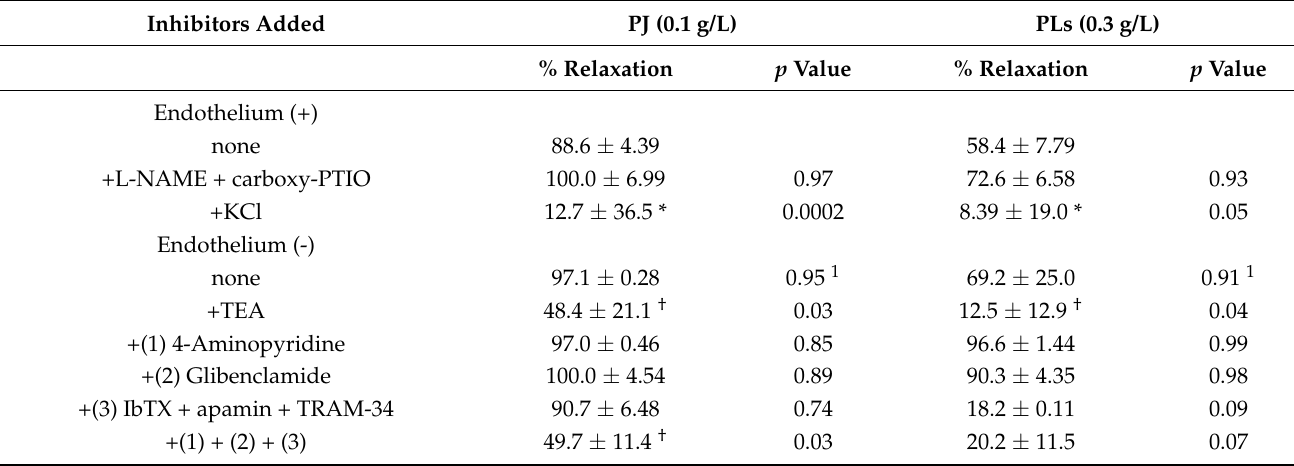
Table 1. Effects of various inhibitors on persimmon juice (PJ)- or persimmon leaf (PLs)-induced vasorelaxation in rat superior mesenteric artery